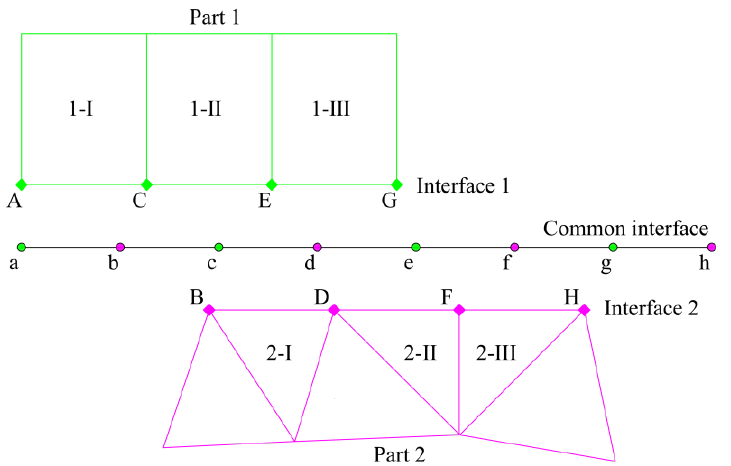
Figure 5. Schematic diagram of information exchange on common interface of sliding mesh method.